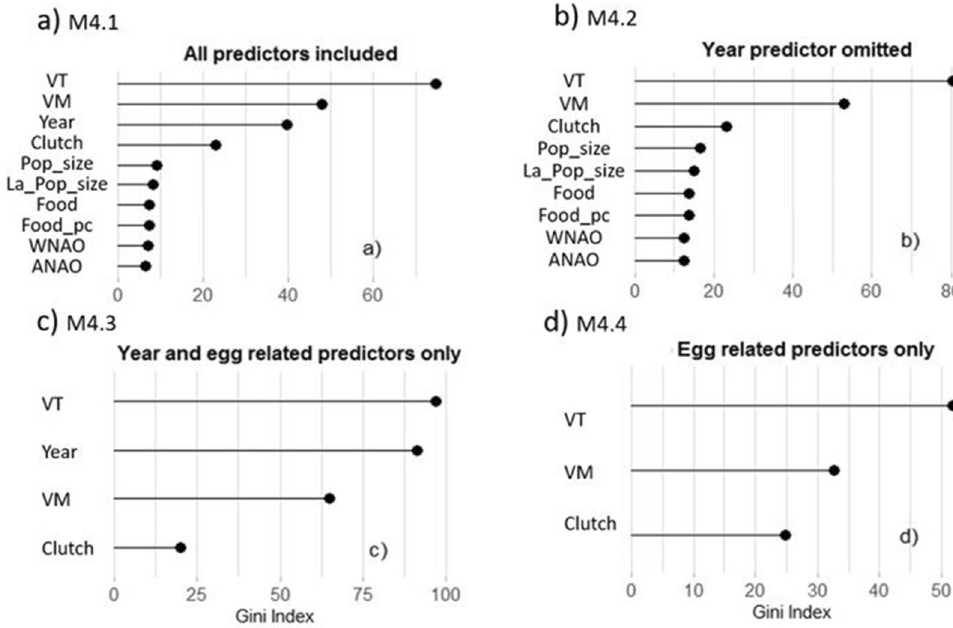
Figure 2. Relative importance of predictor variables (Gini Index) for the 2-age class model (3–4 years old/5+ year old gulls) on the four random forest classification models (M4; see “Methods”). VT total egg volume per nest, VM mean egg volume per nest, Popsize total population size of breeding pairs of Audouin’s and Yellow- legged gulls, La _ Popsize population size of Audouin’s gull only, Food proxy of food availability, Foodpc proxy of per capita food availability, WNAO winter NAO Index, ANAO annual NAO Index. Values are aggregated from 3000 loop bootstrap of subsampling dataset used due to unbalanced age classes. Sample size: 2100 nests. Values of Gini Index are relative and comparable only within each figure part ( a , b , c or d ).